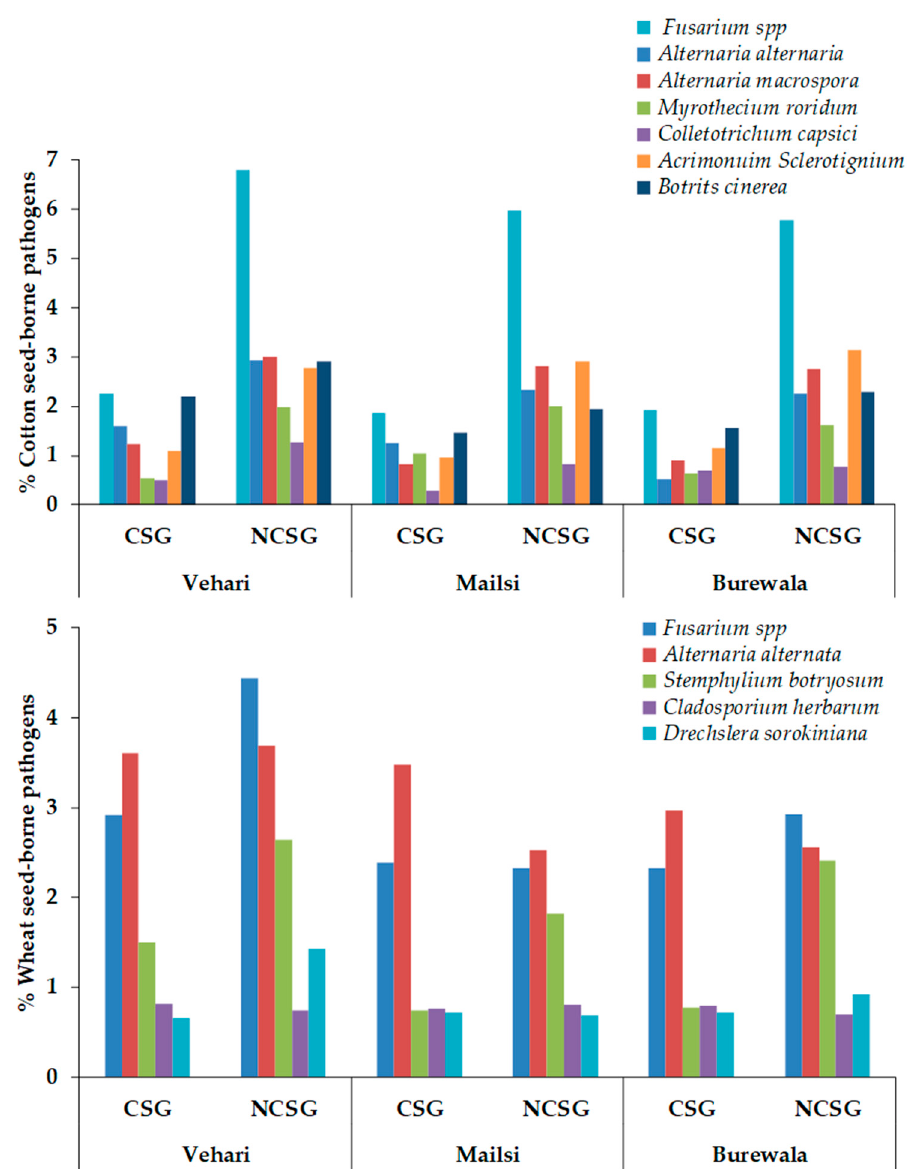
Figure 2. Infestation levels by seed-borne pathogens of cotton and wheat stored seed samples collected from NCSGs and CSGsin Vehari (Pakistan).